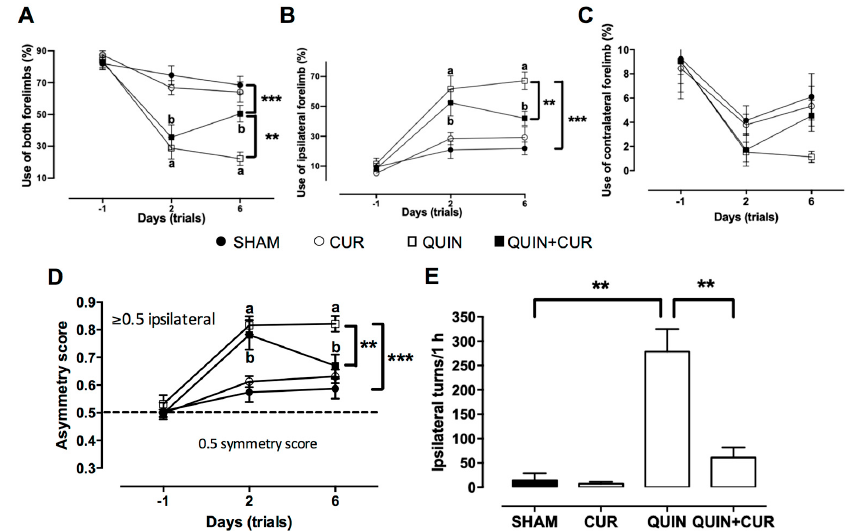
Figure 2. Effect of curcumin (CUR) on quinolinic acid (QUIN)-induced deficit motor skills. Motor evaluation was done on day − 1 (one day before to striatal injection), and days 2 and 6 after QUIN injection; in ( A ) the percentage of use of both forelimbs, in ( B ) the percentage of use ipsilateral forelimb, in ( C ) the percentage of use contralateral forelimb are presented, and in ( D ) the asymmetry score. The rotation behavior test was evaluated at day 6 after QUIN injection; apomorphine (1 mg / kg, s.c.) was administered and the number of ipsilateral turns was quantified for 1 h ( E ). Data are expressed as mean ± SEM ( n = 15). ** p < 0.01, and *** p < 0.001. a p < 0.001 vs. day − 1, and b p < 0.001 vs. day − 1. Panels A–D were analyzed using two-way ANOVA and panel E was analyzed using one-way ANOVA followed by a post hoc Tukey’s